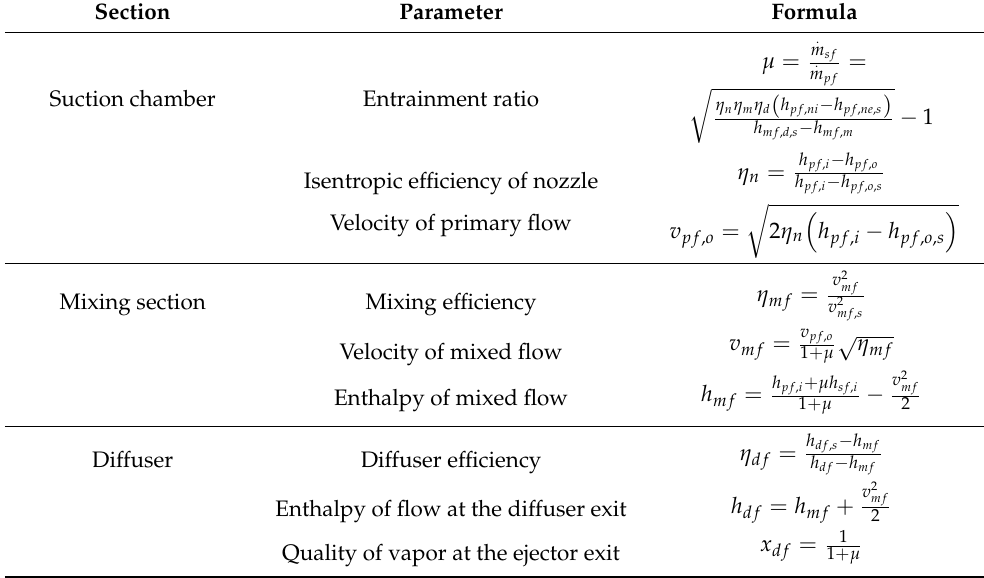
Table A1. One-dimensional ejector model based on energy and momentum conservation.